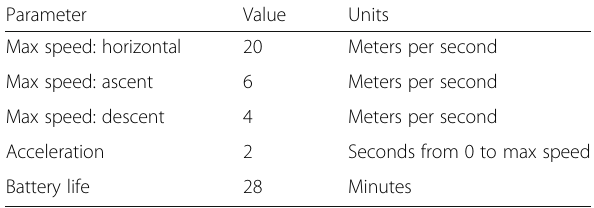
Table 2 UAV parameters used in